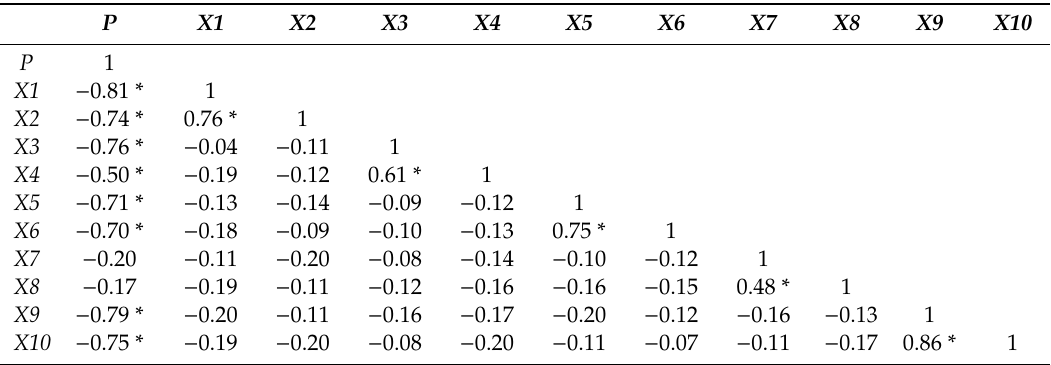
Table 1. Values of paired correlation coe ffi cients between indicators that determine supply at the world oil market and price